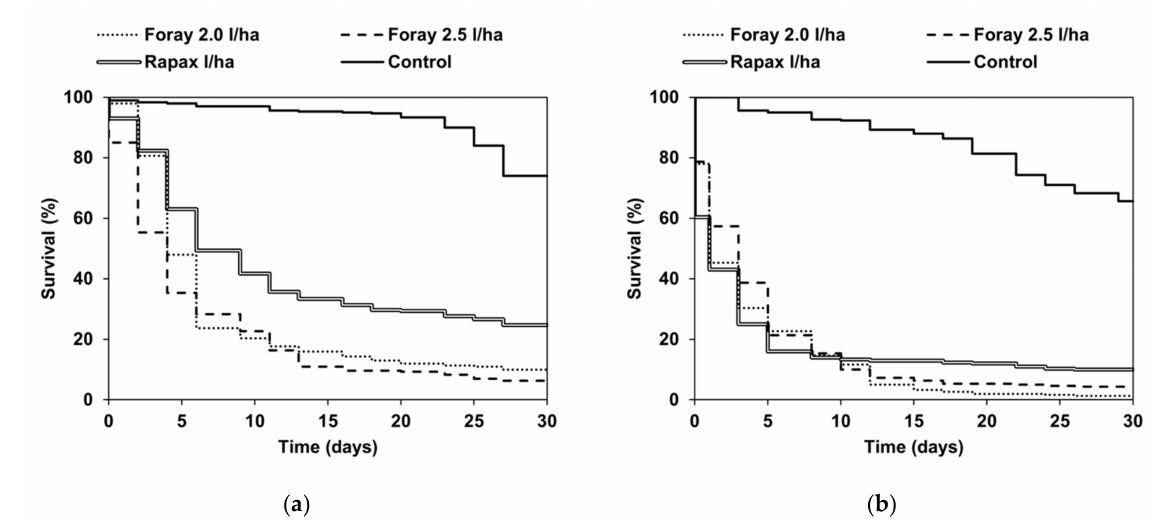
Figure 2. Survival of Lymantria dispar larvae fed in the laboratory with untreated and Btk -treated foliage in ( a ) 2018 and ( b ) 2019. The corrected larval mortality observed in the laboratory in 2018 and 2019 is illus- trated in Figure 3a,b, respectively. In 2018, larval mortality attributable exclusively to Btk formulations was similar 7 (F 2,6 = 3.79, p = 0.09) and 14 (F 2,6 = 5.24, p = 0.05) days after their application in all treatments (Figure 3a). However, significant differences among Btk -based formulations were found 21 days after sprayings, with a lower mortality in larvae fed with Rapax than those fed with Foray at both assayed doses (F 2,6 = 9.69, p = 0.01). In 2019, the average corrected larval mortality observed in the laboratory seven days after application was, respectively, 75.4%, 73.9%, and 59.2% for larvae fed with Foray 2.0, Rapax, and Foray 2.5. Larval density decreased over time and the reduction of reared larvae reached more than 80% in all treatments 21 days after the application. No differences in larval mortality among treatments attributable to Btk were found at different times of observation (7 days after application: F 2,6 = 0.51, p = 0.62; 14 days after application: F 2,6 = 1.03, p = 0.41; 21 days